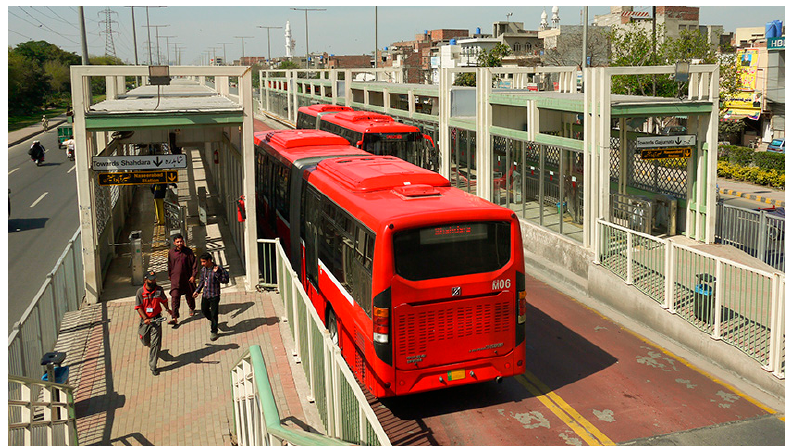
Figure 6. Lahore BRT system.